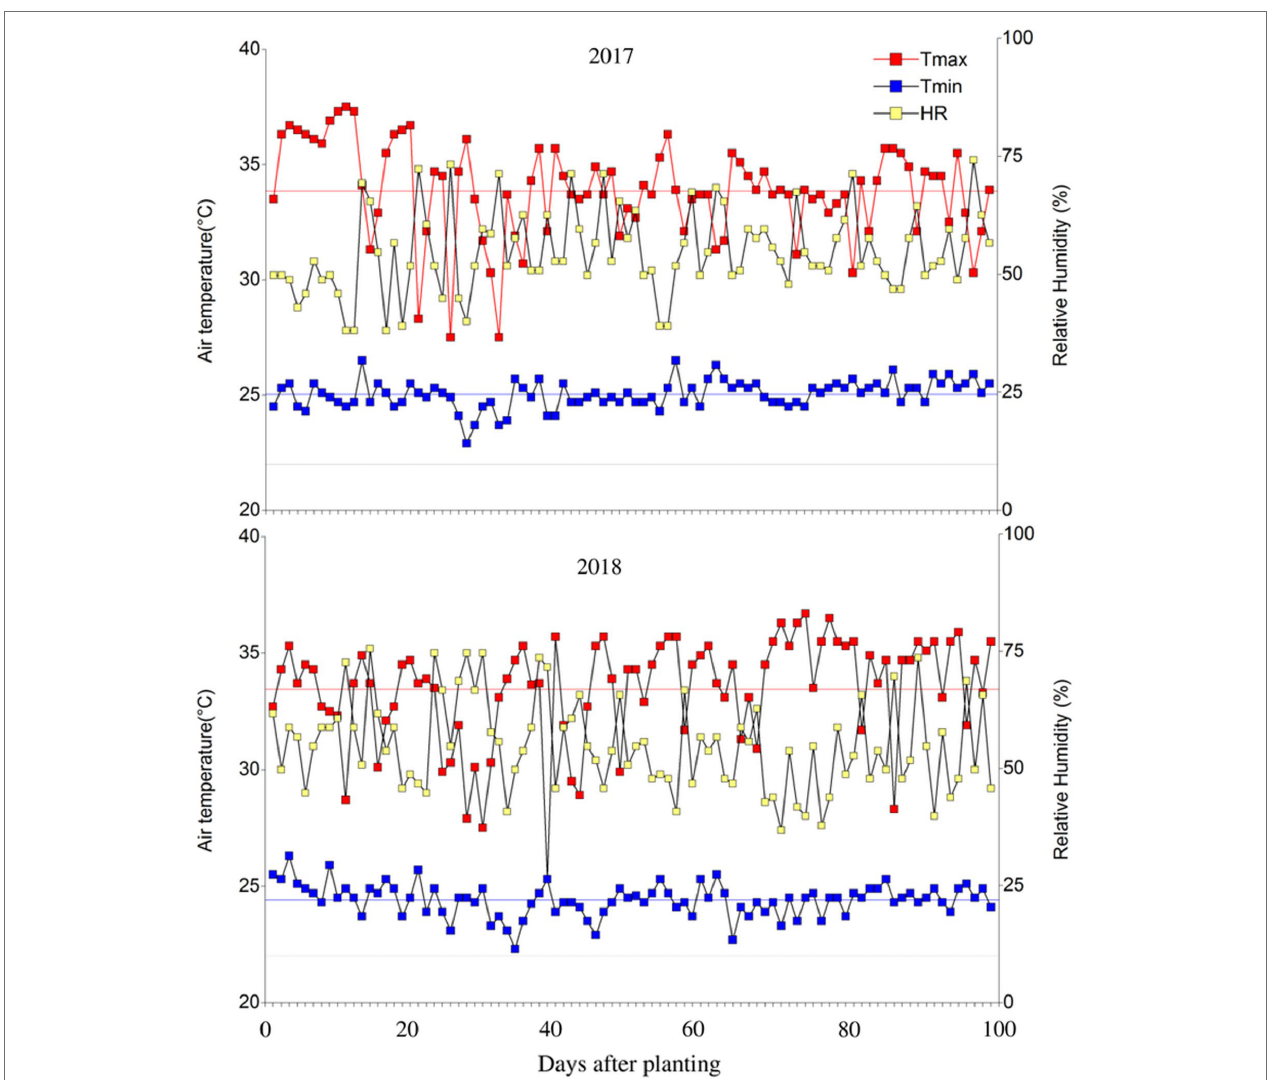
FIGURE 1 | Distribution of maximum/minimum temperatures and relative humidity during the crop growing period under greenhouse conditions at Centro de Investigaciones Amazónicas CIMAZ Macagual, Universidad de la Amazonia, Colombia in two seasons (2017) and (2018). The black line is a mean temperature of 22 ° C. Red and blue line means the average of the maximum and minimum air temperature, respectively. 2017: Tair max : 33.86 ± 0.22 ° C, Tair min : 25.03 ± 0.06 ° C, RH: 56.19 ± 0.94%. 2018: